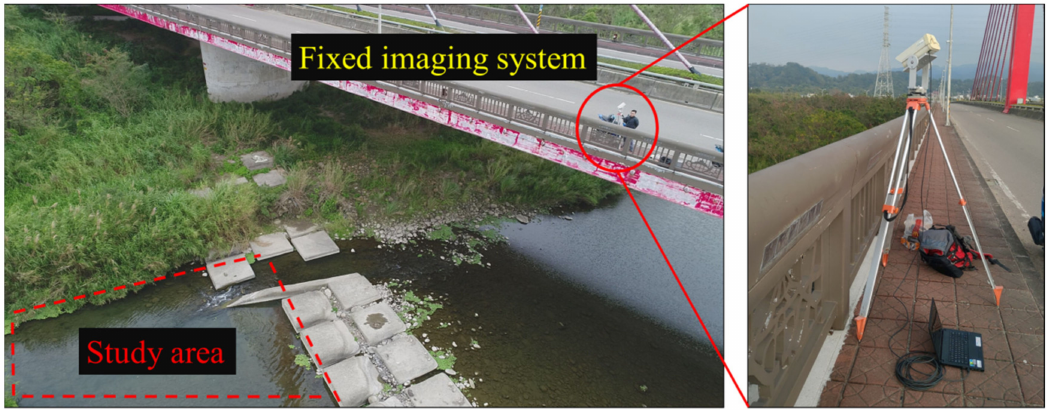
Figure 2. A terrestrial fixed imaging system was placed on a bridge to take images. To make the shooting range of the camera cover the FOV, the shooting direction of the terrestrial camera and the direction of the river flow display a horizontal angle. The terrestrial fixed station also employs LSPIV to analyze images. Therefore, the surface velocities measured by UAV-based LSPIV and terrestrial fixed stations are also